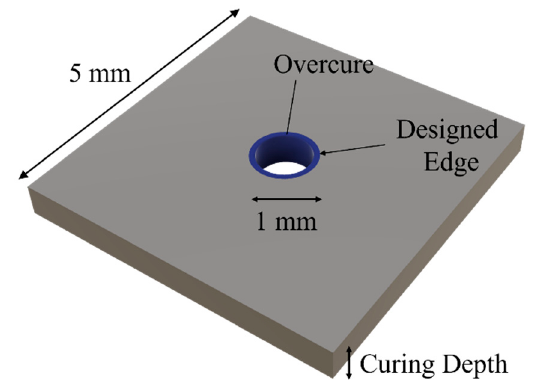
Figure 4. Test specimen of 5 × 5 mm with a 1 mm diameter hole in the center.